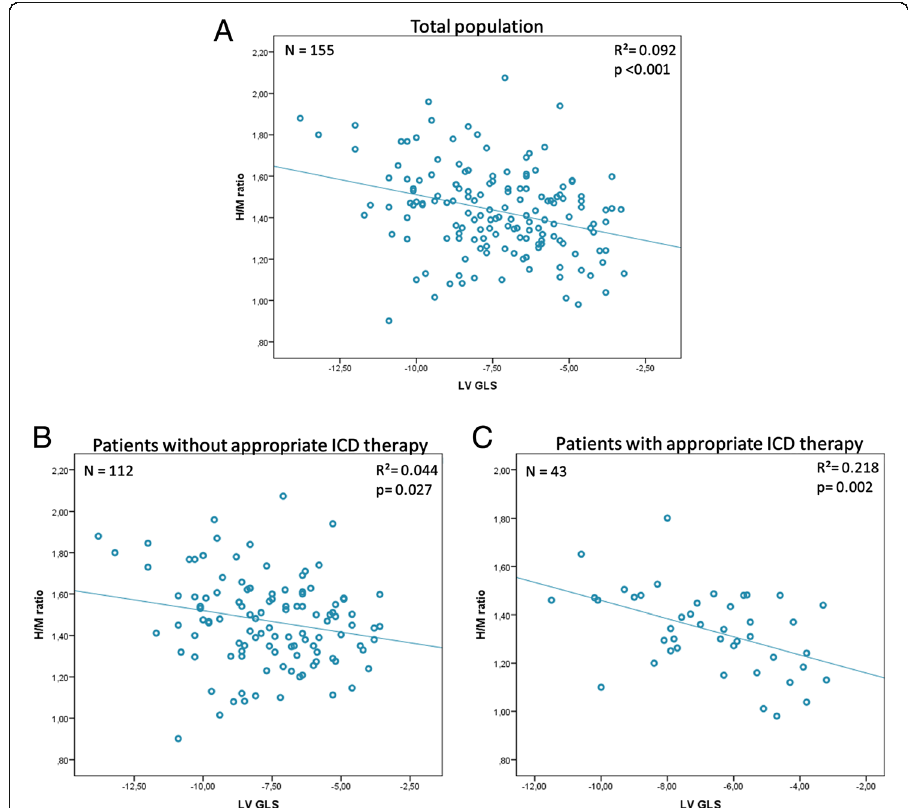
Fig. 2 Correlation between H/M ratio and LV GLS. Correlation between heart-to-mediastinum (H/M) ratio and left ventricular global longitudinal strain (LV GLS) in the total population ( a ), patients who did not experience an event ( b ) and patients who did experience an event ( c ). There was a significant correlation between H/M ratio and LV GLS using the Pearson correlation coefficient for the total population ( r =0.30, p <0.001), patients who did not experience an event ( r = − 0.21, p =0.027) and those who did ( r = − 0.50, p